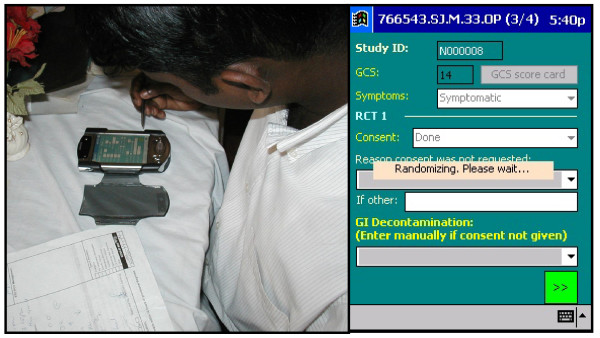
The hand held computer used to recruit and randomise patients and to record all events. Randomisation was performed at the patient's bedside. Allocation could not be predicted by the study doctor.